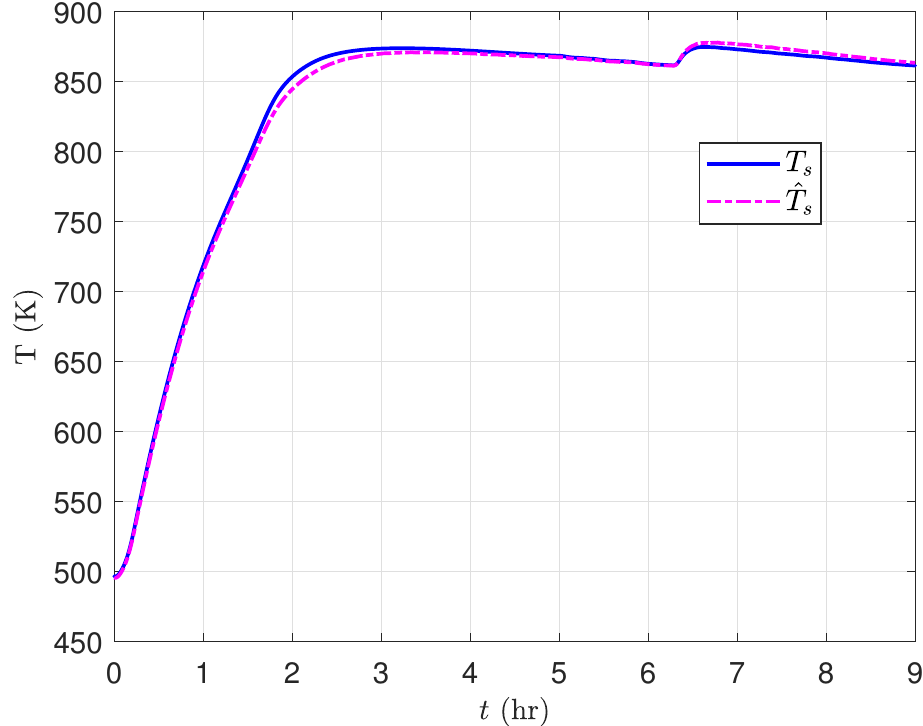
Figure 10. True and reconstructed solid temperature with